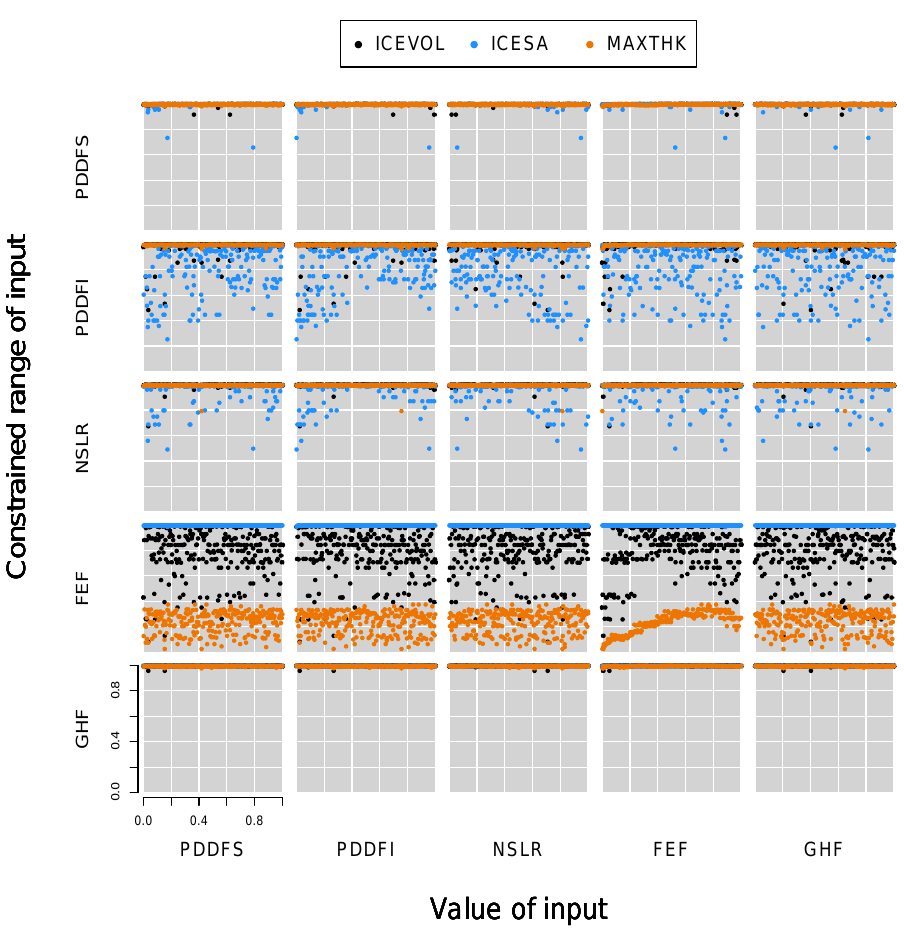
Fig. 9. The extent to which an input can be marginally constrained when we observe an output depends upon (a) the output type, and (b) the location of the output (and hence input) within the ensemble. Here we plot the extent to which an input can be constrained (height on the y axes), against its position in the input space of the ensemble ( x axes), for the three different output summaries. We see that, for example, input parameter FEF can be very strongly constrained if the true value of FEF is